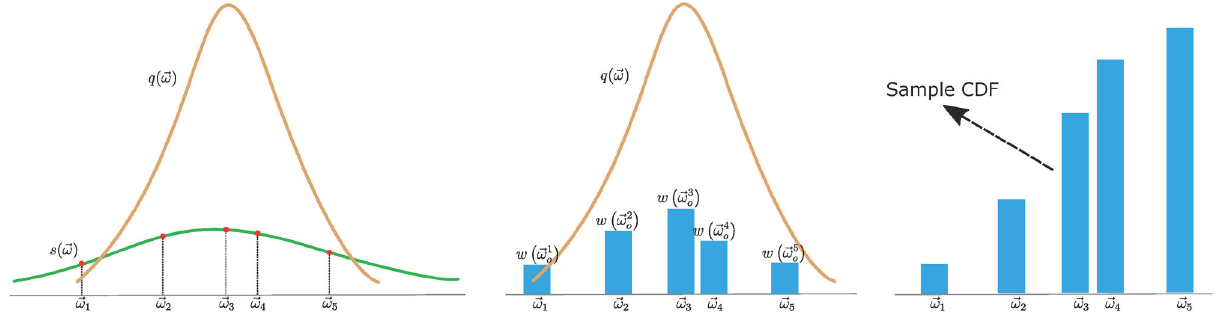
Fig. 5 To sample the target function (orange), we first choose a function as the source function (green), and then sample the source function to get 5 outgoing direction candidates. In the second step, we evaluate the weight of each candidate, the target function value divided by the source function value. Finally, we compute the cumulative distribution function of the candidates’ weights and use it to get the final